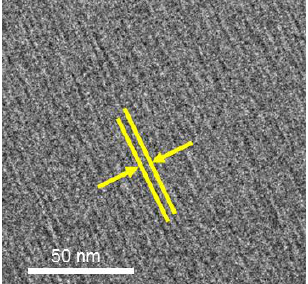
Figure 5. Cryo-TEM image of 2C 12 (2-O-2) NTf 2 .